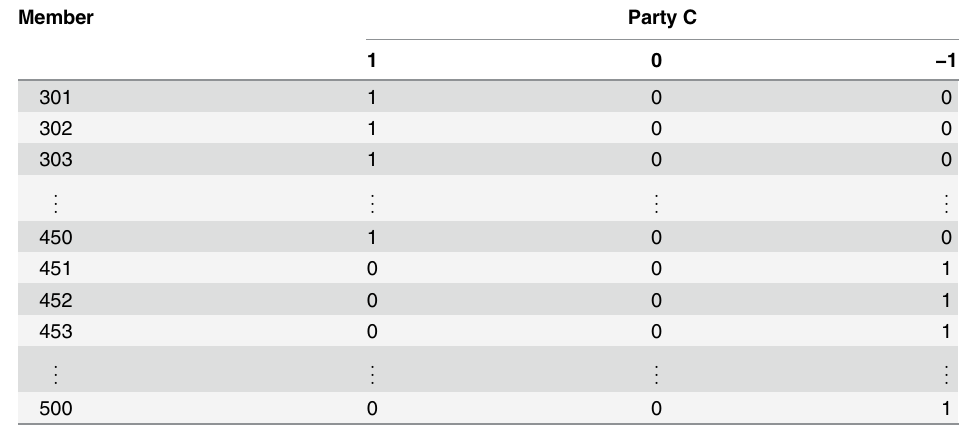
Table 5. A decomposition of Table 2 into multi-tables of Boolean-valued for Party C.